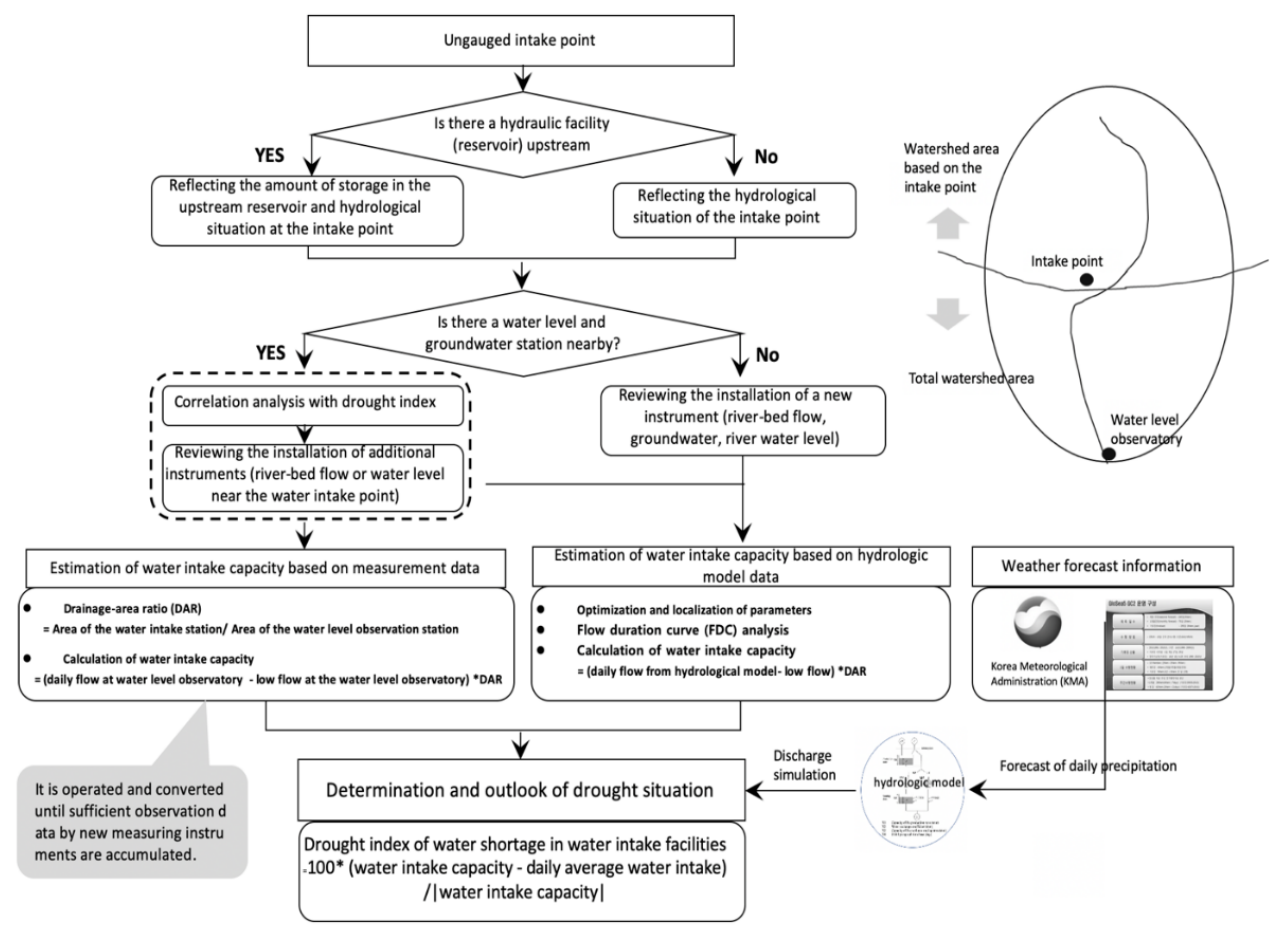
Figure 1. Drought condition criteria and monitoring procedure for the ungauged intake point.